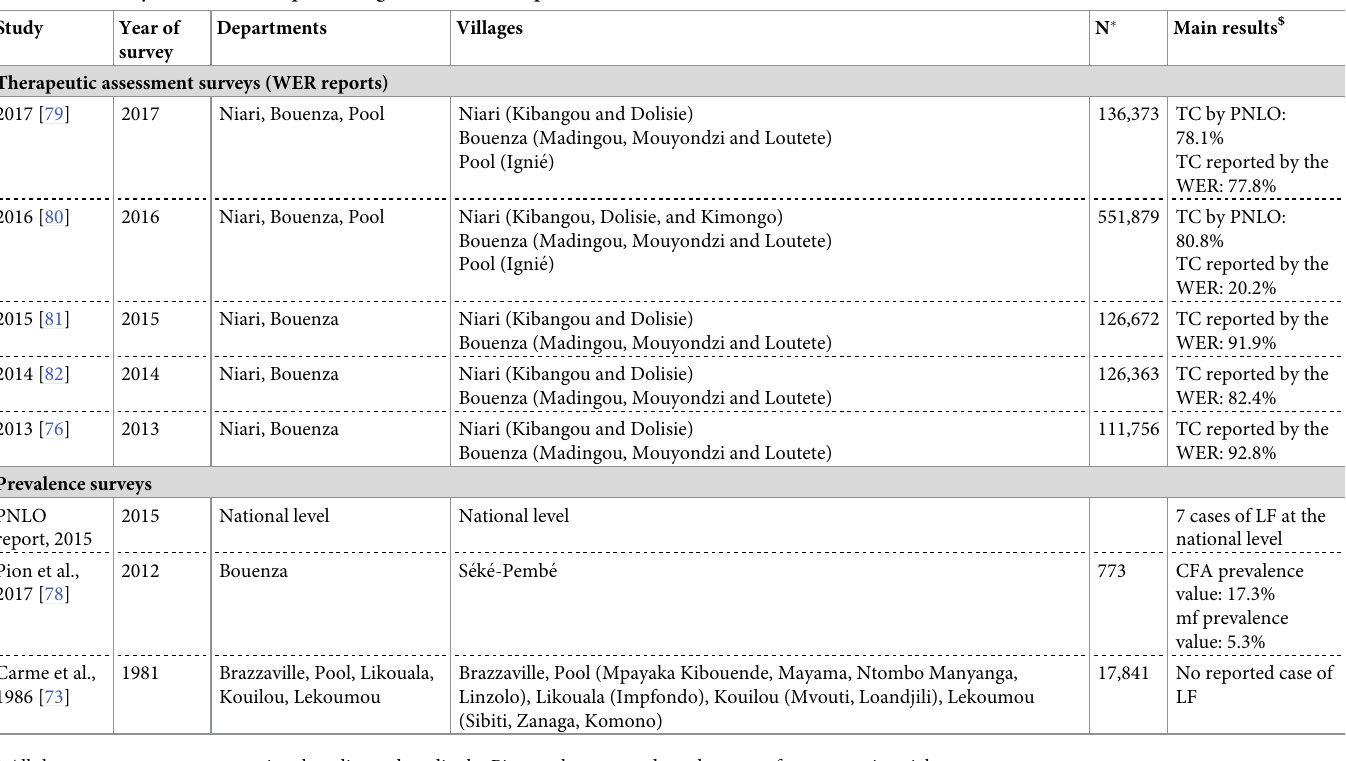
Table 2. Summary of the included epidemiological studies and reports on